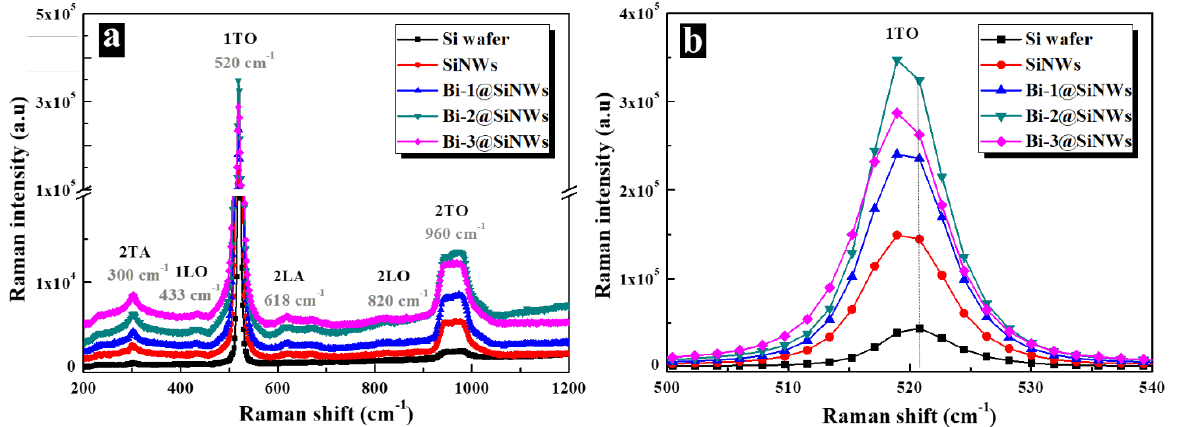
Figure 3. ( a ) Raman spectra of bulk Si, SiNW and Bi-modified SiNW samples. The curves are slightly shifted vertically to enable comparison. ( b ) Comparison of the first-order Raman spectra for different samples.